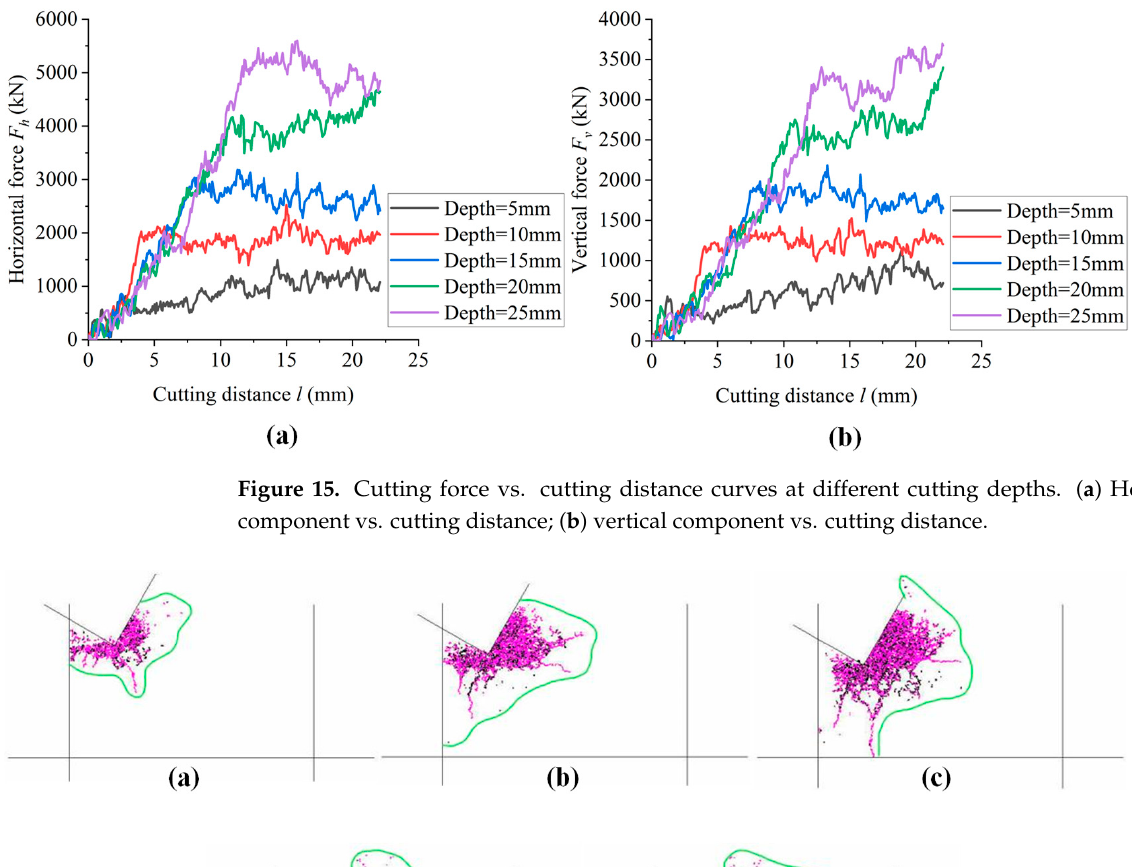
15 of 30 Figure 14. Cutting failure of numerical specimens with different cutting depths: ( a ) 5 mm; ( b ) 10 mm; ( c ) 15 mm; ( d ) 20 mm; ( e ) 25 mm. Figure 15 shows the relationship between the horizontal and vertical components vs. cutting distance under different cutting depths. It can be seen from Figure 15a and Figure 15b that the horizontal force on the cutter is greater than the vertical force. Comparing the curves of different samples, it was found that the effect of cutting depth on cutting force is very significant. With the increase in cutting depth, the cutting force significantly in- creases. For samples with a large cutting depth, such as 20 mm and 25 mm, the displace-